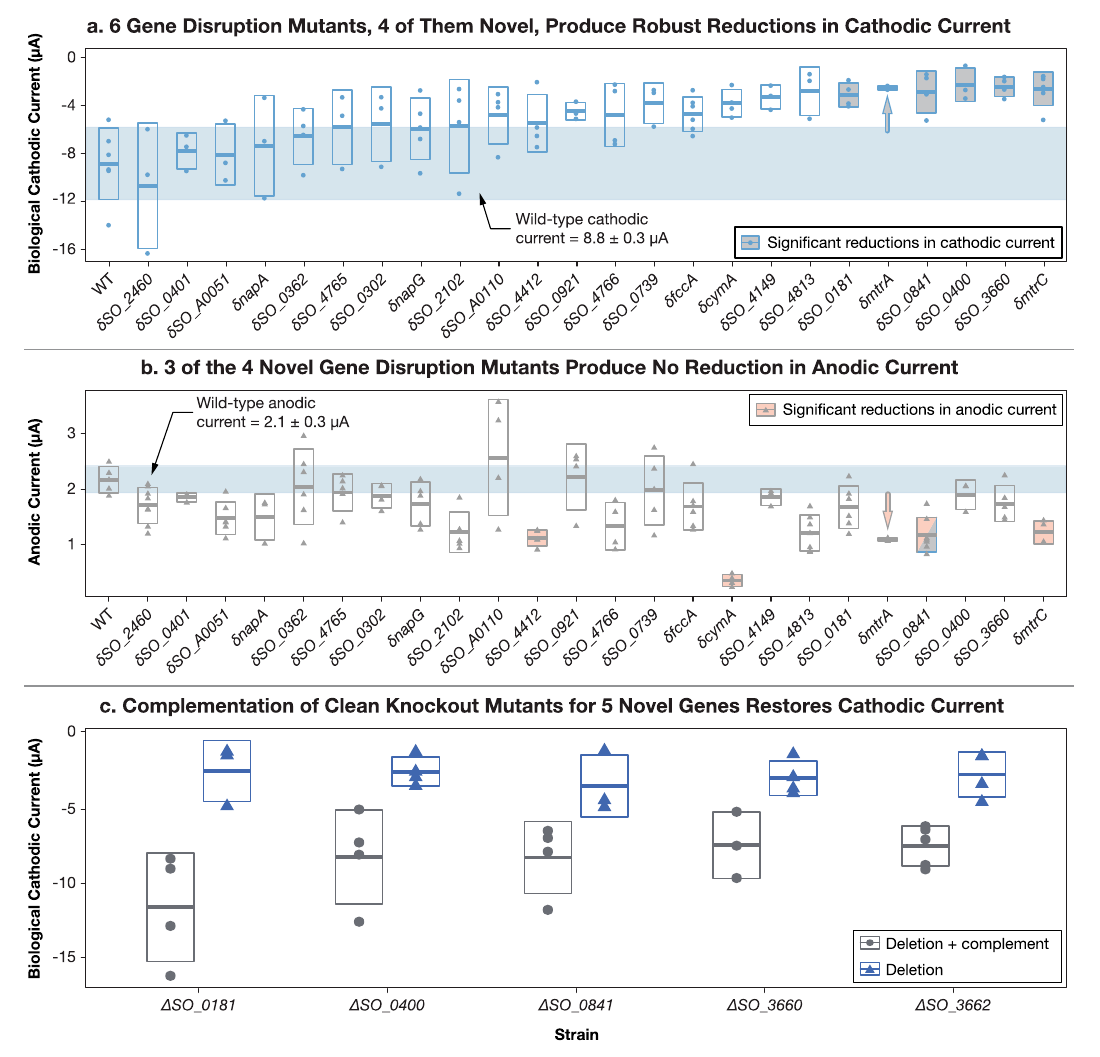
Fig. 3 Electrochemical measurements con fi rm robust extracellular electron-uptake phenotype for 5 S. oneidensis mutants identi fi ed by our high- throughput screen ( δ SO_0181 , δ SO_0400 , δ SO_0841 , δ SO_03660 and δ SO_03662 ; ( δ indicates a transposon-insertion mutant)). δ SO_03662 was implicated in electron uptake by the AHDS red oxidation assay. However, at the time of collecting data for panels a , b , we were unable to retrieve δ SO_03662 from the S. oneidensis whole-genome-knockout collection, so later constructed a clean deletion mutant to collect data for panel c . Hence, we talk about four mutants in panels a , b , but 5 in panel c . We were later able to retrieve δ SO_3662 mutant and retested it in the AHDS red oxidation assay prior to submitting this article. The δ mtrA control mutant in panels a , b shows signi fi cant derivation from wild type, but the current range is too small to be drawn clearly, so is marked with arrows. a We measured the cathodic biological current for 18 S. oneidensis mutants that produced AHDS red oxidation failure for unknown reasons, control mutants ( δ fccA , δ mtrA , δ mtrC , and δ napG ), and wild type (WT). In total, 6 gene-disruption mutants, four of them previously uncharacterized, produced robust reductions in cathodic current. The region corresponding to wild-type currents and one standard deviation is shaded in blue. ANOVA results indicated that there was a signi fi cant variation in means of the strains from one another ( F -value = 5.94; Pr(> F ) = 2.34 × 10 − 9 ), while individual comparisons speci fi cally revealed δ SO_0181 , δ mtrA , δ SO_0841 , δ SO_0400 , δ SO_3660 , and δ mtrC to all display signi fi cantly lower cathodic currents ( p < 0.05) than WT. b However, three of the six robust electron-uptake mutants (three of the four previously uncharacterized disruption mutants) do not have a signi fi cant effect on anodic current production (electron deposition), the well-characterized phenotype of S. oneidensis . The range of wild-type current values and a standard deviation from the mean is shaded in blue. Analysis of anodic current values ( F -value = 5.801, Pr(> F ) = 2.10 × 10 − 10 ) revealed that of the four previously uncharacterized disruption mutants, only δ SO_0841 shows anodic current production different from WT ( p < 0.05). c Gene deletion (indicated by Δ ) con fi rms the electron uptake phenotype of fi ve mutants. Complementation of the deleted gene restores electron uptake phenotype. Further information on electrochemical methods can be seen in Materials and methods. Data are available in ref. 53